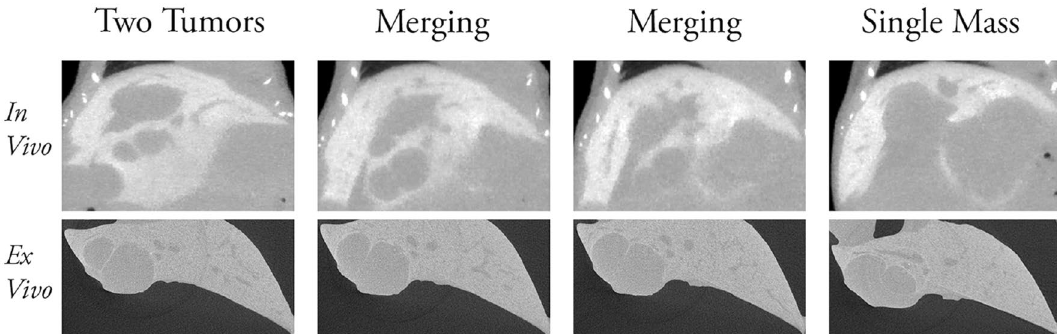
Figure 3. Tumor merging observed on in vivo and ex vivo micro-CT imaging. The merging of two tumors in the liver of the same mouse was compared in the in vivo and the ex vivo micro-CT images. The two separate tumors merged somewhere inside the liver. The merging progression occurs over more slices in the ex vivo image due to higher resolution of this technique.